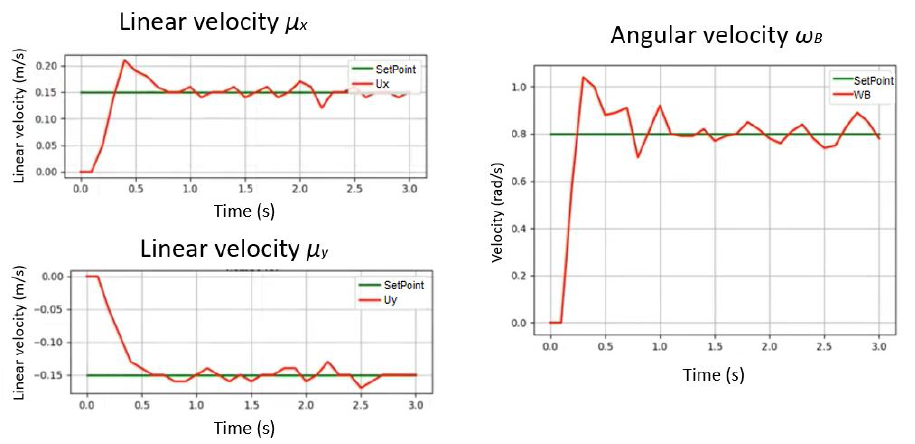
Figure 24. Desired values indicated in the state machine and the PID control responses for each variable µ x , µ y and w B